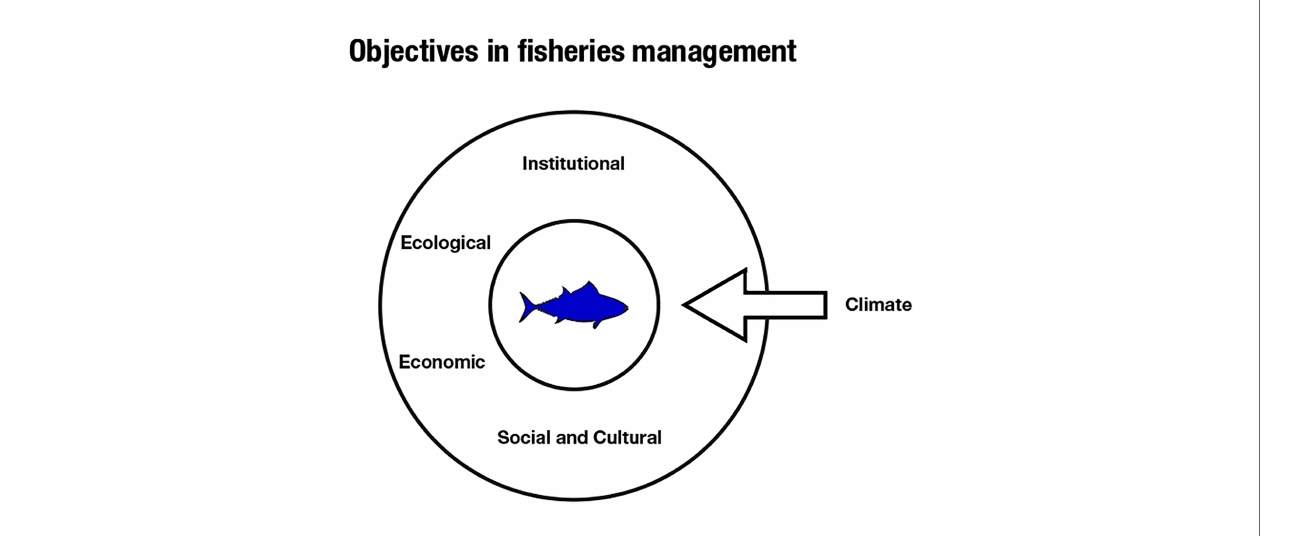
FIGURE 2 | Objectives in Fisheries